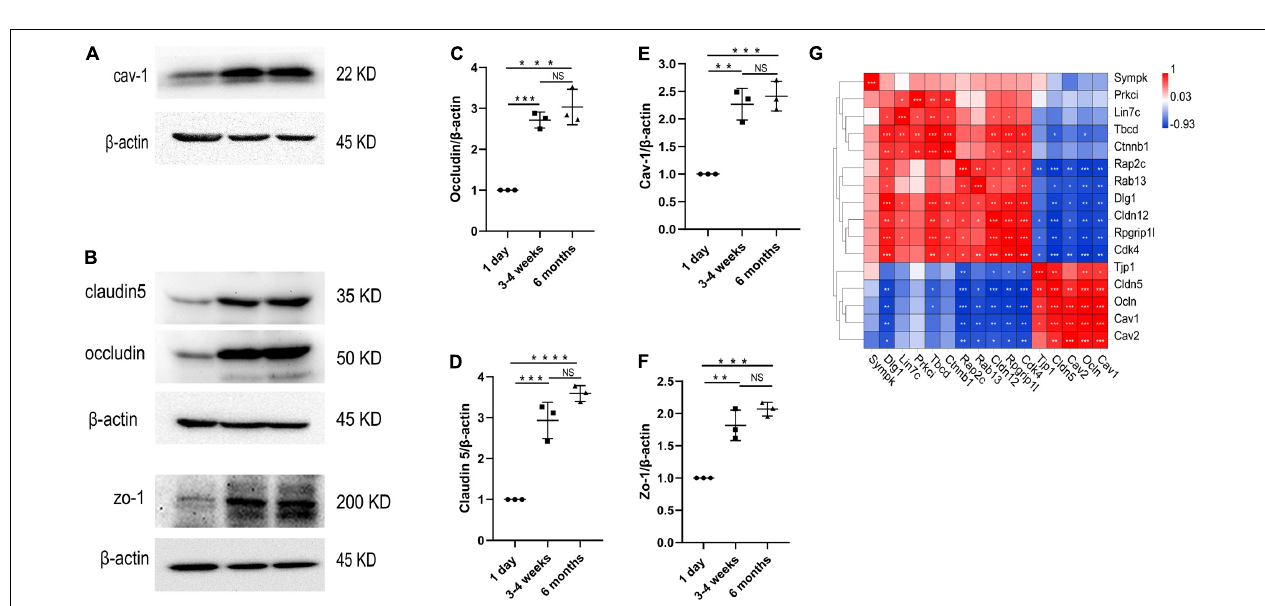
FIGURE 5 | Changes in protein levels of TJs and cav-1 in the cerebral cortex microvessels. (A–F) Western blotting analysis and quantification of cav-1, zo-1, claudin5 and occludin expression in the cortex microvessles at three different time points ( n = 3); Mean values ± SD, NS, not significant; * p < 0.05, ** p < 0.01, *** p < 0.001 and **** p < 0.0001 compared to the Sham group; one-way ANOVA followed by Dunnett’s post hoc test. (G) Correlation heat map analysis of cav-1, cav-2 and TJs genes.